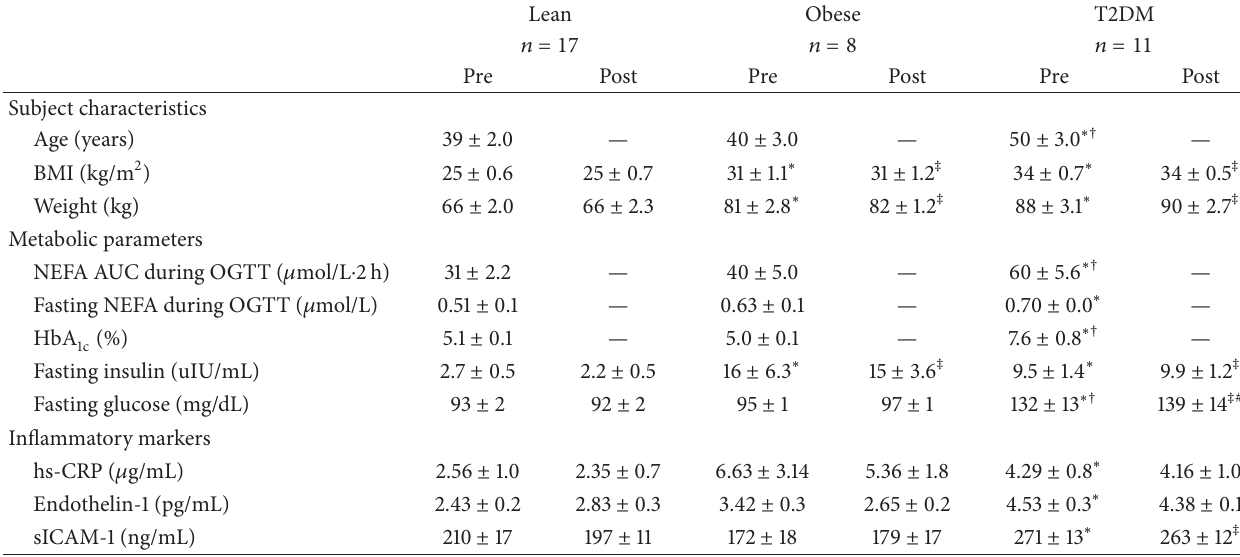
Table 1: Subject characteristics, metabolic parameters, and inflammatory markers pre and post exercise training. Lean Obese T2DM 𝑛 = 17 𝑛 = 8 𝑛 = 11 Pre Post Pre Post Pre